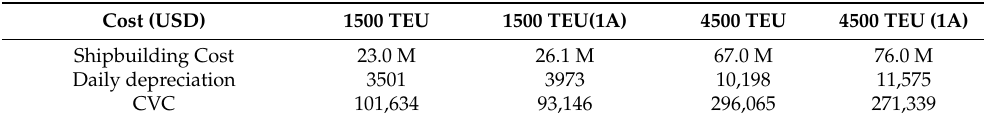
Table 3. Shipbuilding costs and